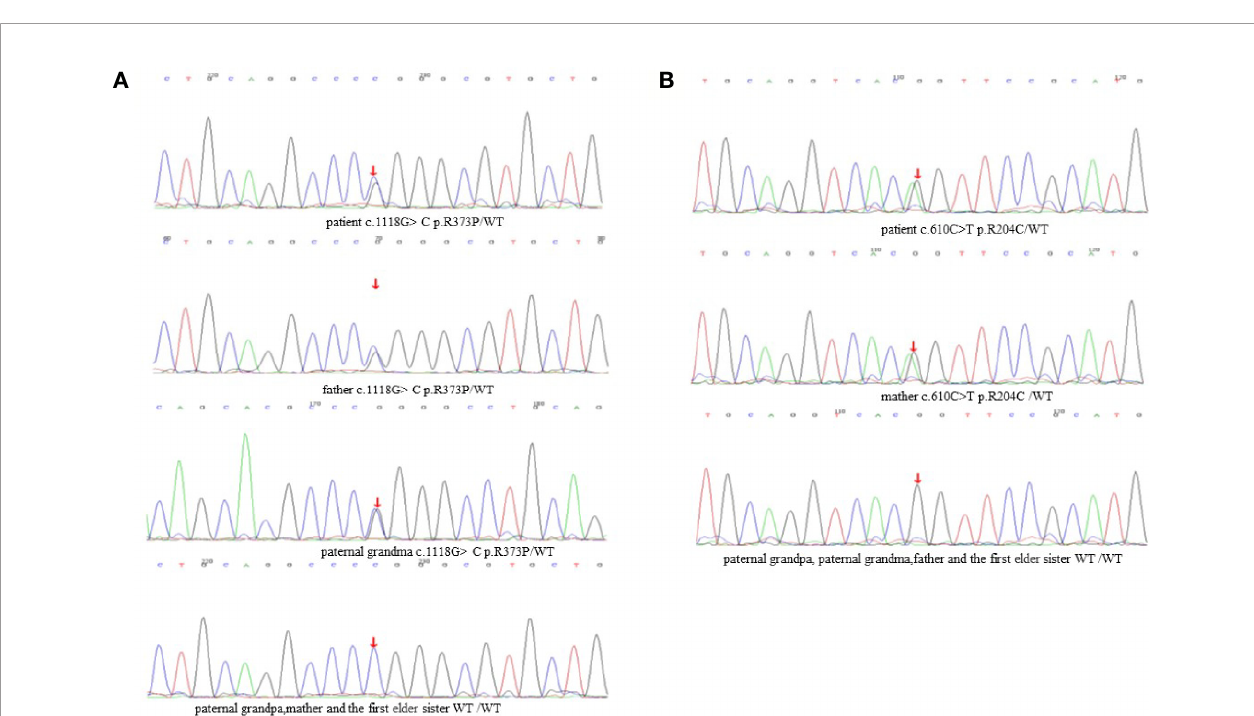
FIGURE 2 | Family evaluation of CARD9 . (A) c.1118G>C p.R373P variation in exon 8. (B) c.610C>T p.R204C variation in exon